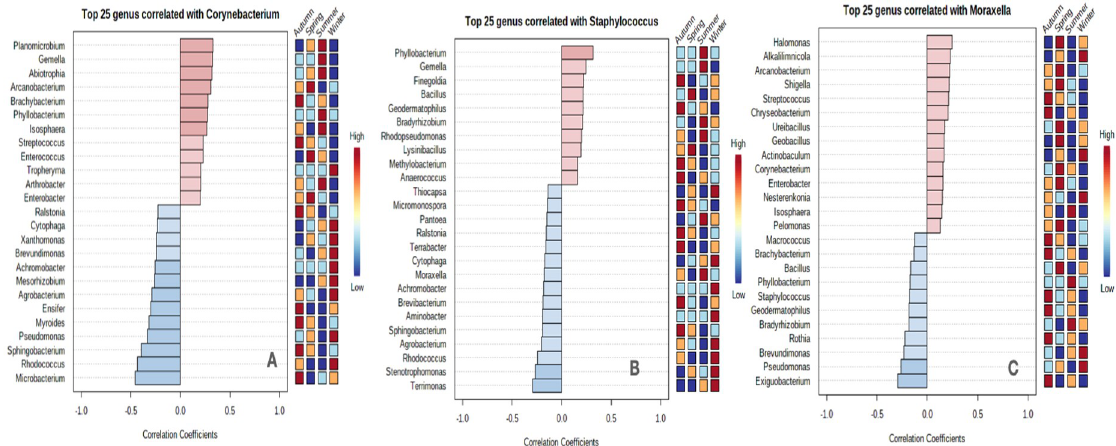
Fig 8. Pattern search analysis through SparCC showing positive and negative correlations of three pre-dominant genera (A) Corynebacterium , (B) Staphylococcus and (C) Moraxella . Correlations among the top 25 genera are presented on the bar plots. The genera are ranked by their correlation coefficients. The pink bar represents positive correlations and the blue bar depicts negative correlations. The deeper the colour the stronger the correlation. The correlation coefficients are plotted on the X-axis. A heatmap on the right shows the RA of the genera in each season (high-red; low-blue).